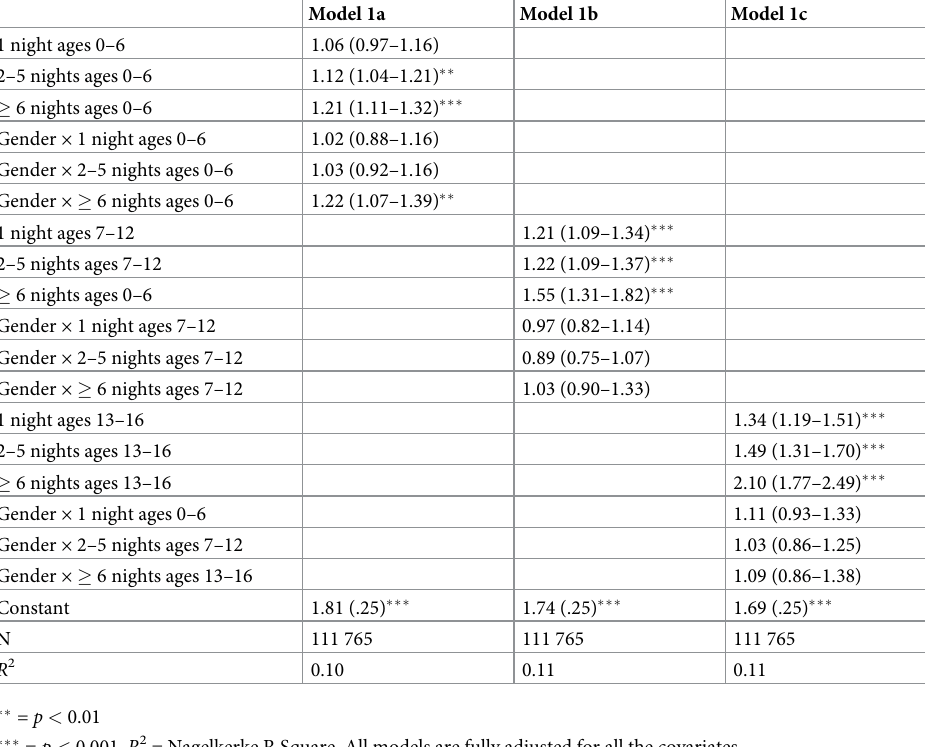
Table 5. Hospitalization timing, gender interactions and odds ratios (OR) for ineligibility for upper secondary education . Confidence intervals in